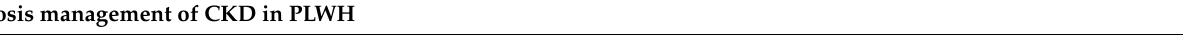
Table 3. Overview of diagnosis and nutritional management of CKD in